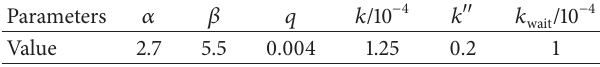
Table 3: Parameters of the working state